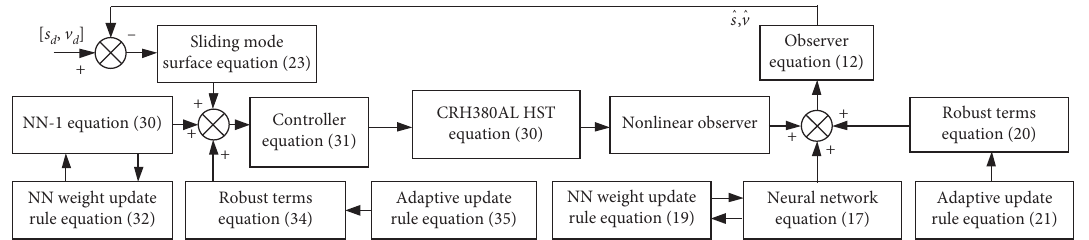
Figure 2: Block diagram of the overall closed-loop HST tracking system. NN: neural network; HST: high-speed